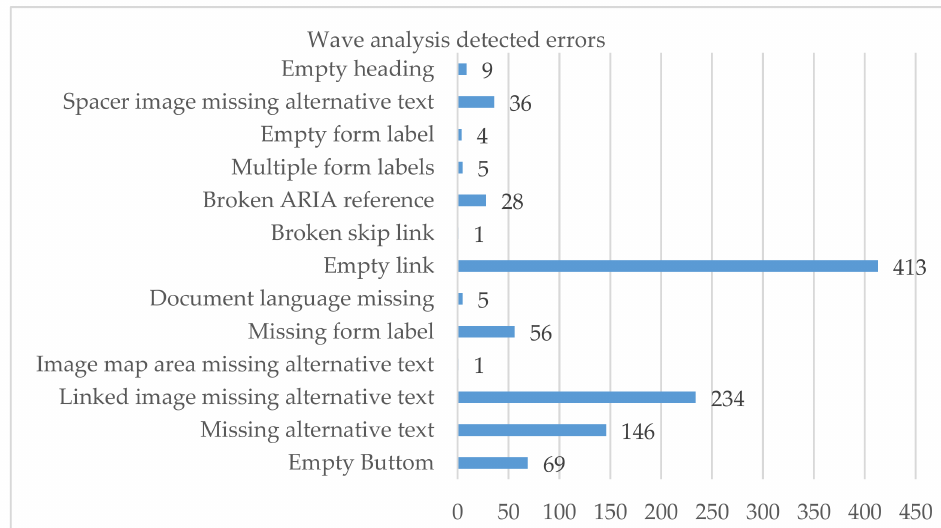
Figure 8. Errors that do not comply with WCAG 2.1 detected in the analyzed sample. Source: own elaboration from Wave